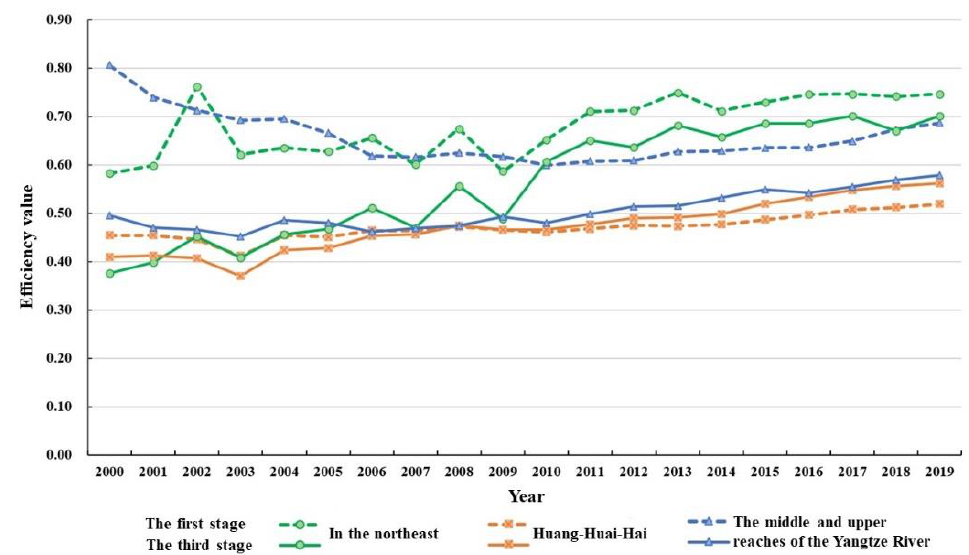
Figure 6. Scatter diagram of pure technical efficiency and scale efficiency after adjustment..